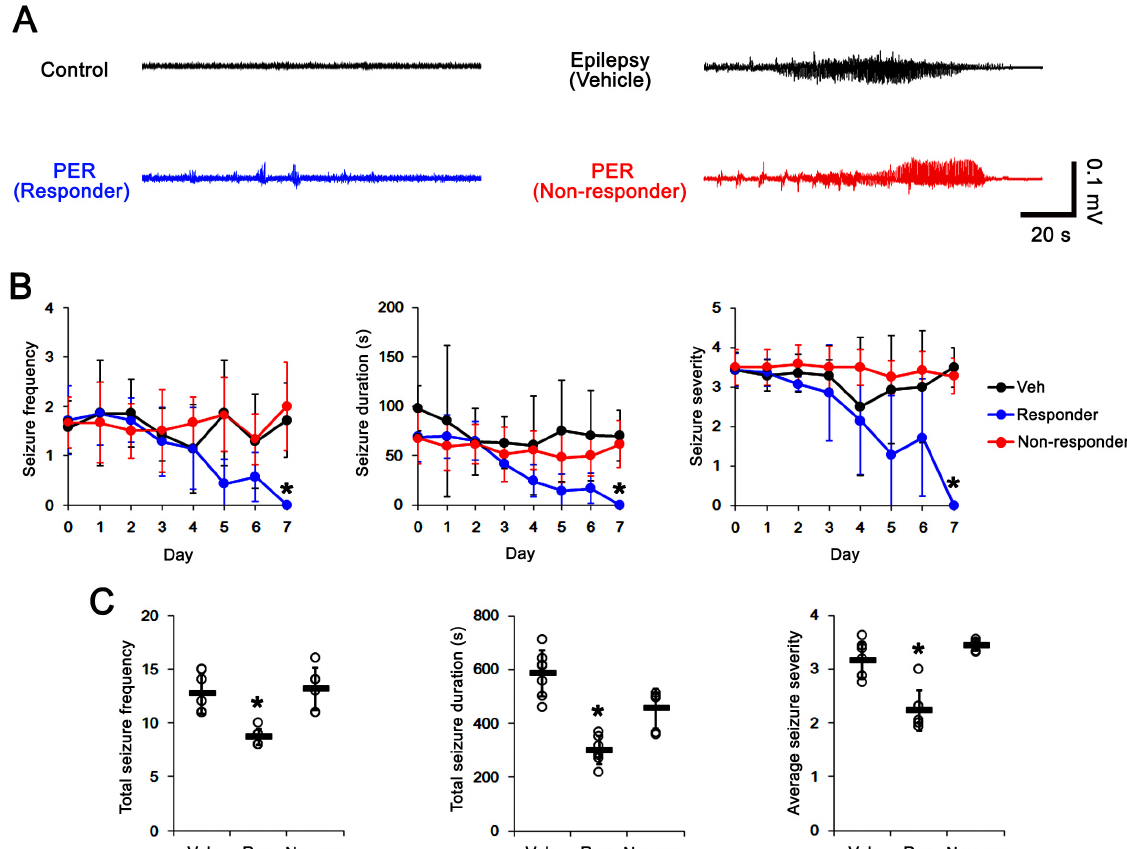
Figure 3. The effects of perampanel (PER) on spontaneous seizure activities in chronic epilepsy rats. PER effectively attenuates spontaneous seizure activities in responders. ( A ) Representative electro- encephalograms (EEG) in each group at 4 days after treatment. ( B ) Quantitative analyses of the chronological effects of PER on seizure frequency, seizure duration and seizure severity (seizure score) over the 7-day period. Error bars indicate SD (* p < 0.05 vs. vehicle (Veh)-treated animals). ( C ) Quantitative analyses of total seizure frequency, total seizure duration and average behavioral sei- zure score (seizure severity) over the 7-day period. Open circles indicate each individual value. Hor- izontal bars indicate the mean value. Error bars indicate SD (* p < 0.05 vs. vehicle-treated animals). 2.2. Effects of PER on TASK-1 Expression in the Epileptic Hippocampus Next, we explored whether the efficacy of PER in spontaneous seizure activity is rel- evant to TASK-1 expression. Consistent with previous studies [36,37,42], TASK-1 expres- sion was prominently detected in glial fibrillary acidic protein (GFAP)-positive astrocytes within the stratum radiatum and stratum lacunosum-moleculare of the CA1 region of control rats ( n = 7). TASK-1 expression was also detected in astrocytes in the molecular layer and the hilus of the dentate gyrus of control rats (Figure 4A). In chronic epilepsy rats ( n = 7), TASK-1 expression was clearly detected in most reactive CA1 astrocytes (hyper- trophy and hyperplasia of cell bodies and processes of astrocytes). However, TASK-1 ex- pression was rarely observed in reactive astrocytes within the dentate gyrus (Figure 4A). TASK-1 fluorescence intensity was increased to 1.63-fold of control level ( p < 0.001, one- way ANOVA with Bonferroni’s post hoc test; Figure 4A,B). In responders ( n = 7), PER reduced TASK-1 fluorescence intensity to 1.21-fold of control level ( F (2,17) = 32.7, p < 0.001, one-way ANOVA with Bonferroni’s post hoc test), but not non-responders ( n = 6; Figure 4A,B). Western blot also revealed that TASK-1 density was elevated to 1.62-fold of control